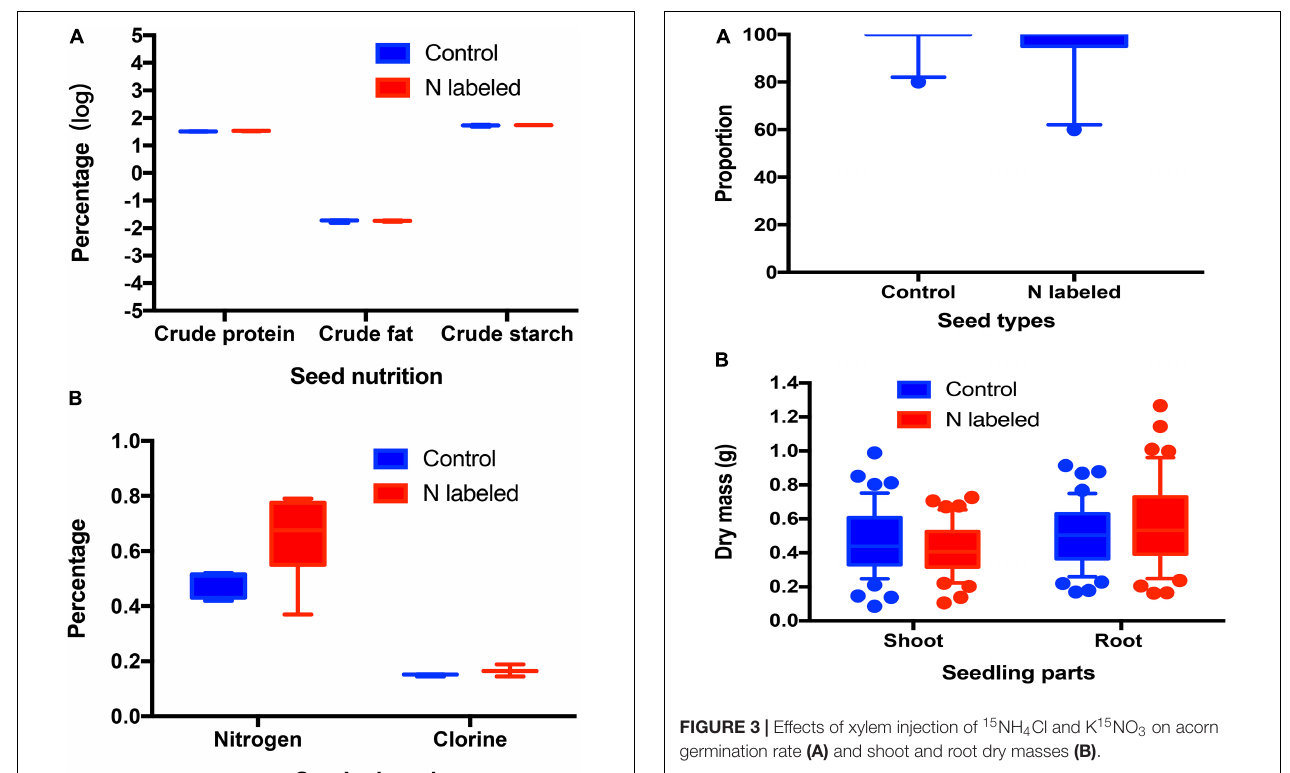
Seedling Recruitment Based on Isotopic Signals in